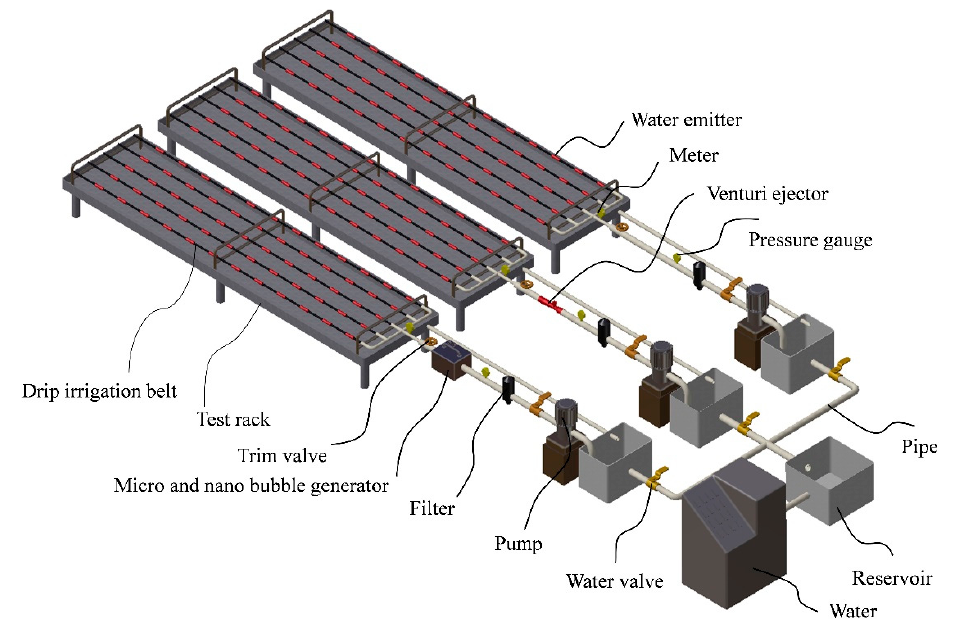
Figure 1. Schematic diagram of test device.